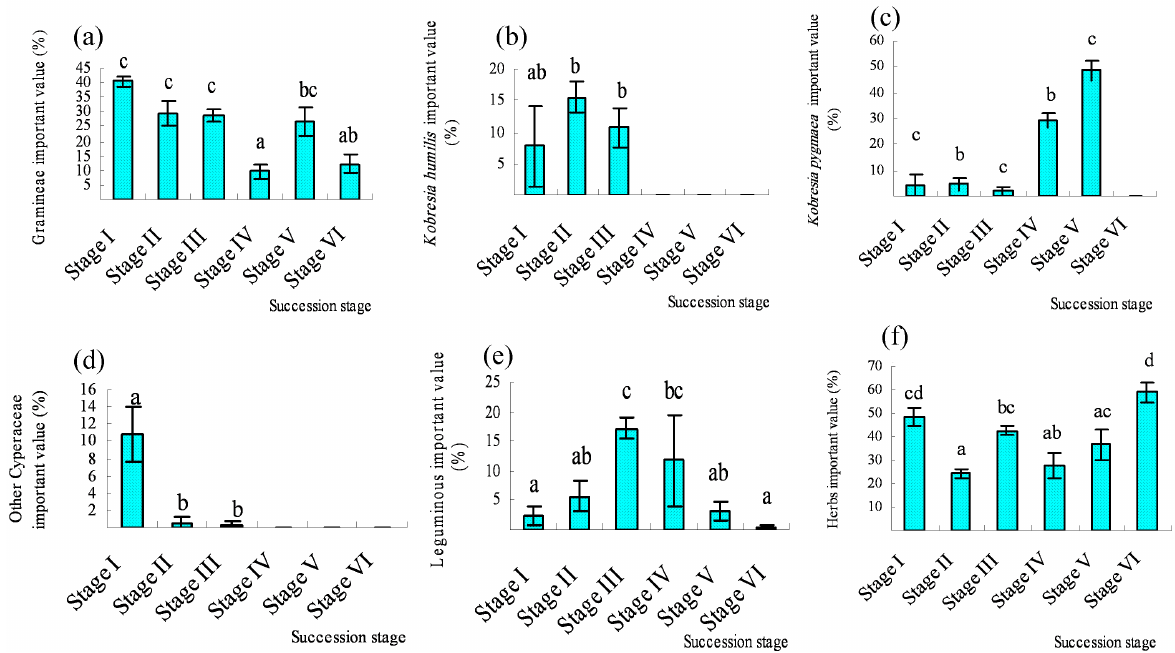
Figure 3. The characteristics of the four plant functional groups in a degradation successional series of Tibetan alpine grasslands: (a) Gramineae, (b) Kobresia humilis , (c) Kobresia pygmaea , (d) other sedges, (e) Leguminosae, and (f) Forbs. Different letters in the figures indicate significant differences between the stages at P <0.05.